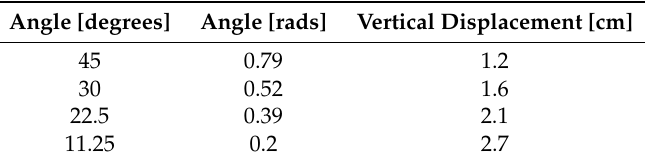
Table 10. Vertical average distance.